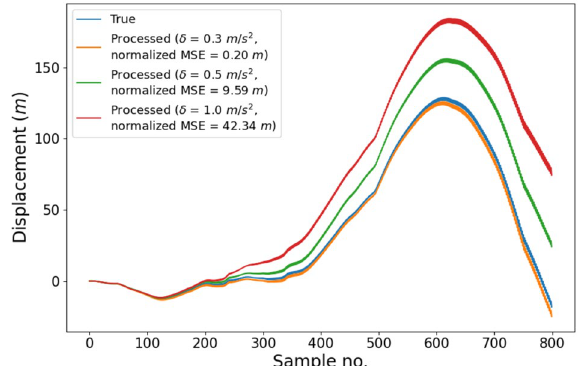
Figure 8. Displacement computation for various error thresholds. For threshold up to 0.3 m/s 2 , the accuracy of displacement computation is not